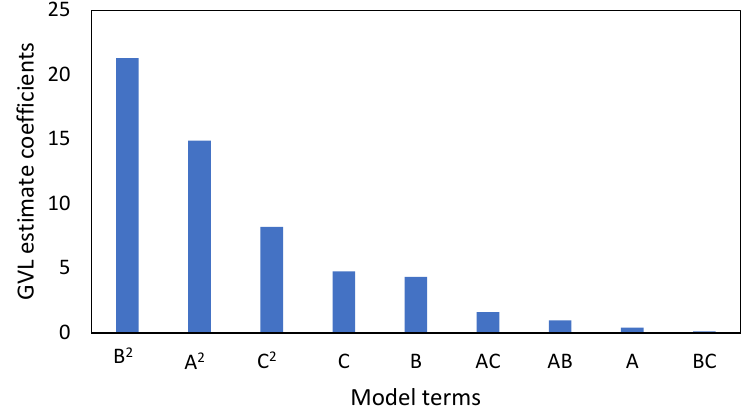
Figure 3. GVL pareto chart of the model terms which illustrate the terms that have more effect on the GVL yield. Investigated model terms are temperature ( A ), time ( B ), and catalyst loading ( C ). The response surface and contour plots (Figure 4a–c) illustrate the interaction of the investigated factors (time, temperature, and catalyst loading) to produce GVL from com- mercial LA. Figure 4a indicates that both temperature and time are signi fi cant to GVL yield. The minimum temperature (25 °C) and time (2 h) yielded a low GVL yield (46.7%). Increasing the temperature to 112.5 °C and time to 6 h resulted in maximum GVL yield (78.6%); however, increasing the temperature and reaction time to 200 °C and 10 h, respec- tively, resulted in a marked decrease in GVL yield (39.2%). Therefore, a temperature of 112.5 °C and time to 6 h are the optimum conditions for GVL production from LA using MsOH as the catalyst.